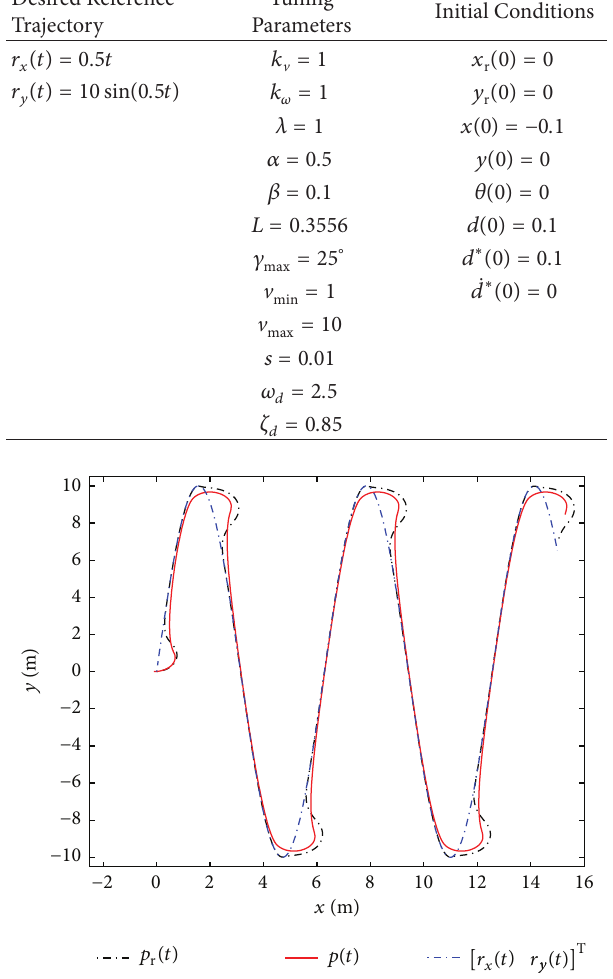
Figure 10: Sinusoidal trajectory with saturation algorithm.